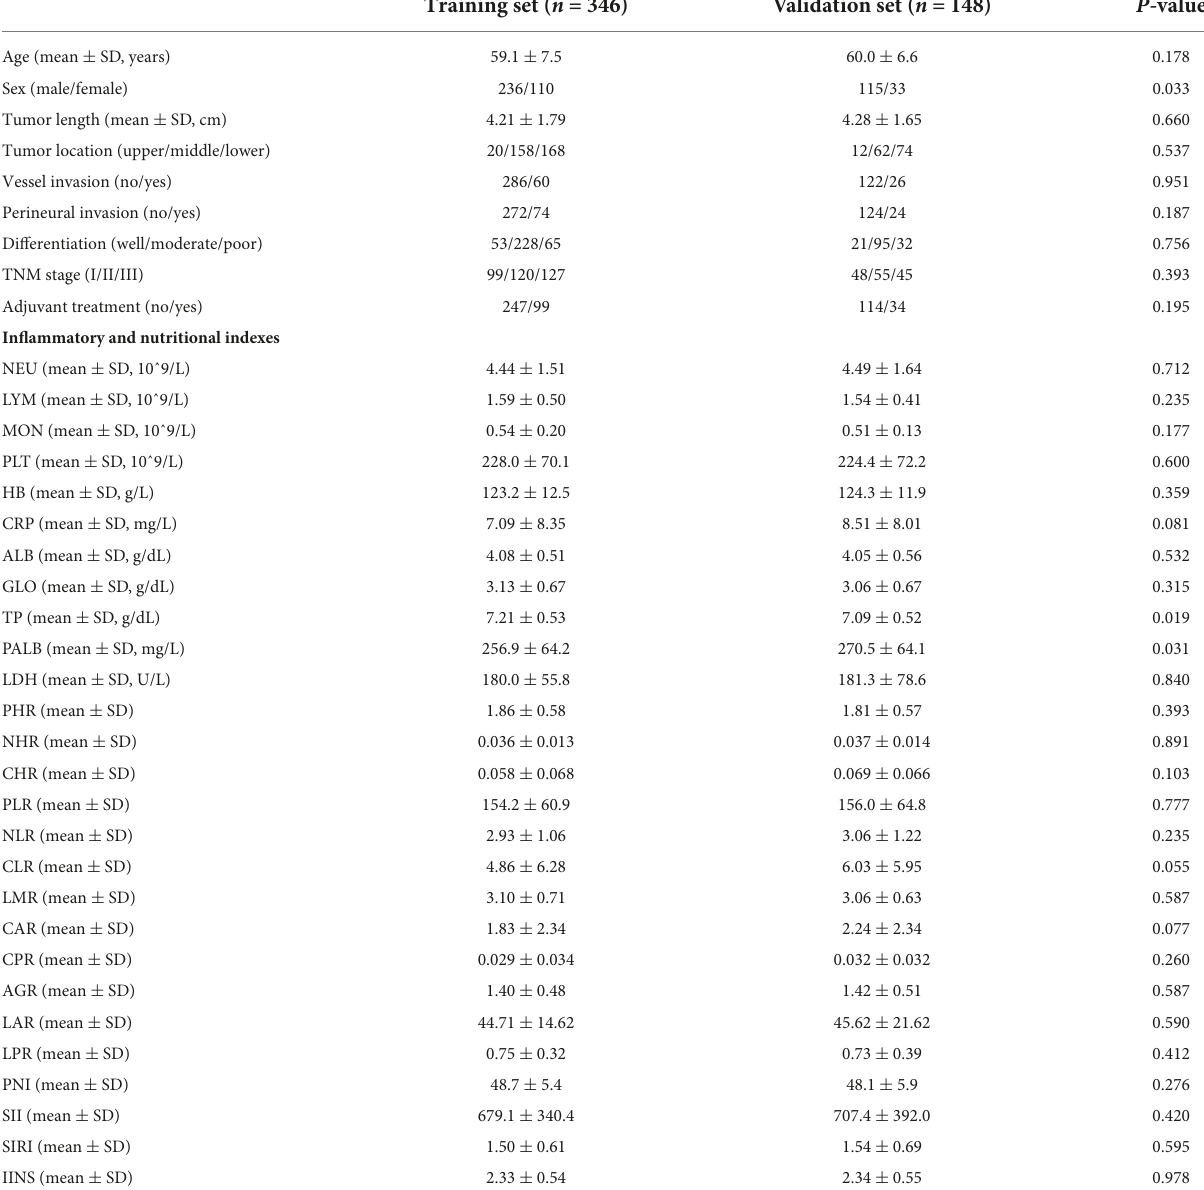
TABLE 1 Comparison of the baseline characteristics in the training and validation